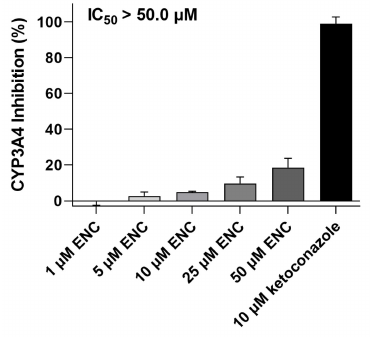
Figure 7. Encorafenib does not induce meaningful inhibitory effects on CYP3A4 isoenzyme’s activity. Experiments were conducted by using a commercial Vivid™ CYP3A4 screening kit according to the provided protocol. For the normalization, raw data from the vehicle control (0.5% DMSO) with/without CYP3A4 enzyme served as the maximal/non-enzyme activity sample. Normalized data were utilized for calculating the IC 50 value. Experiments were performed as 3 independent repetitions. ENC, encorafenib; error bar, standard